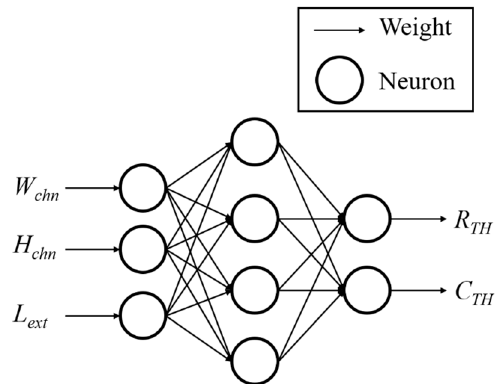
Figure 5. Schematic of a neural network model for thermal characteristics.